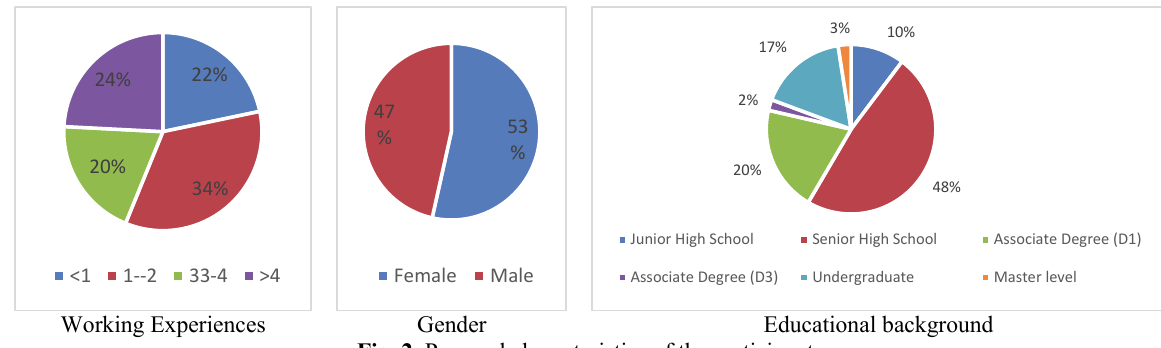
Fig. 2. Personal characteristics of the